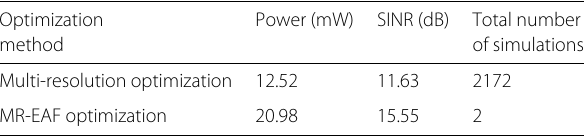
Table 5 Simulation results of